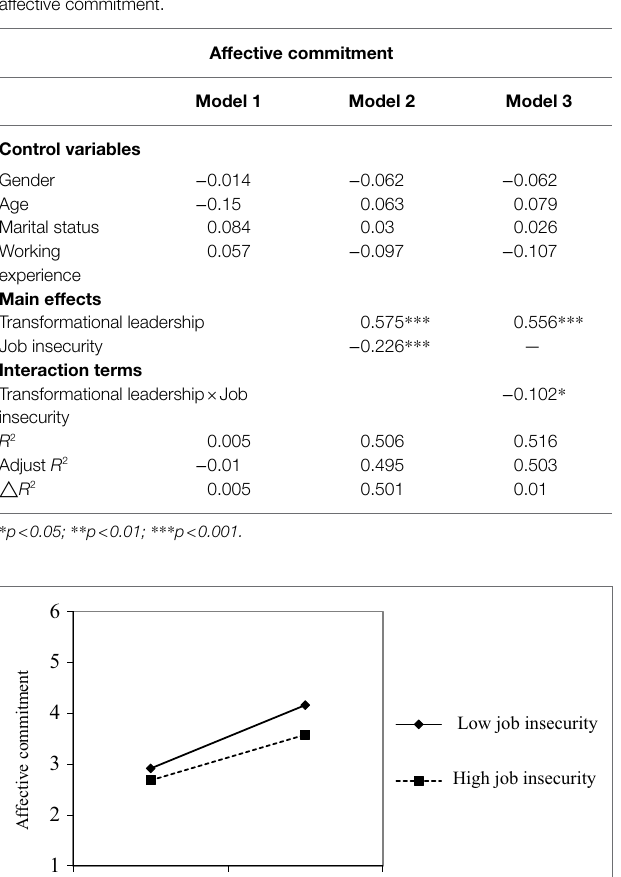
TABLE 5 | Regression analysis of transformational leadership and affective commitment.